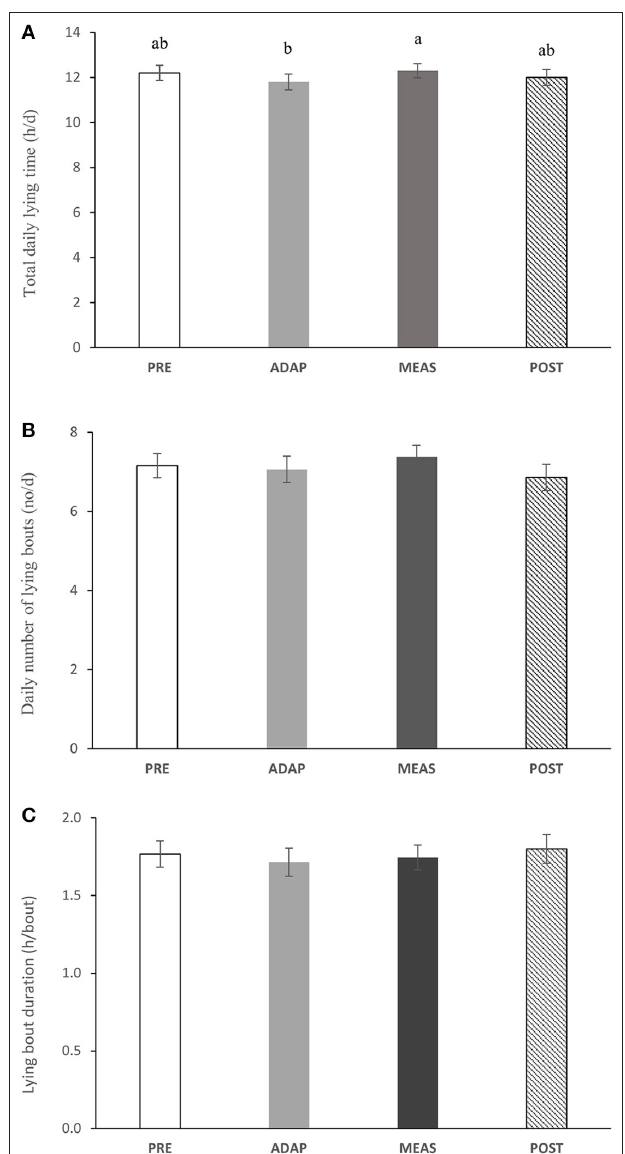
FIGURE 2 | Effect on behavior of cows wearing sulfur hexafluoride (SF 6 ) equipment to measure enteric methane (CH 4 ) emissions in each of four phases [PRE, Before cows had the equipment on; ADAP, initial period of fitting; MEAS, During the enteric methane (CH 4 ) measurements; POST, after the SF 6 equipment was removed] on (A) total daily lying time (h/d), (B) daily number of lying bouts (no/d) and (C) lying bout duration (h/bout).